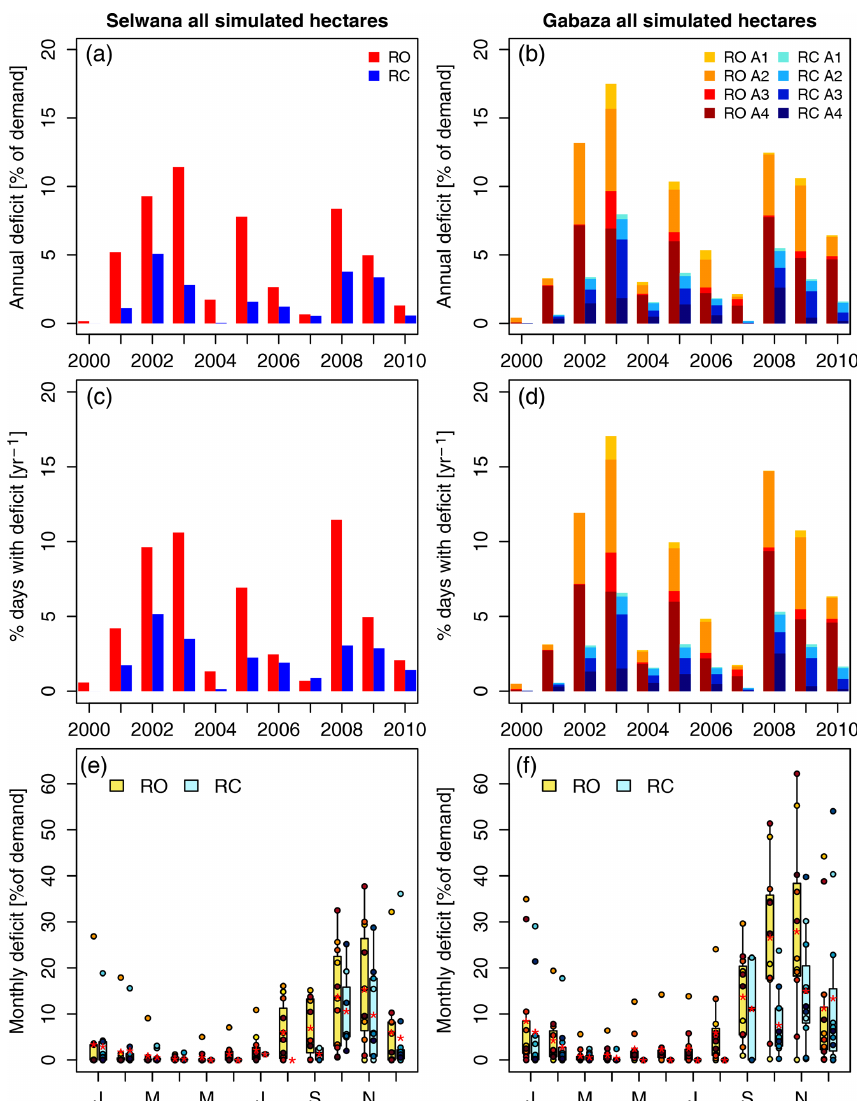
Figure 9. The demand-specific annual deficit across all simulated hectares, and the percentage of grazing days integrated across all simulated hectares that had a deficit (irrespective of the size of the deficit), relative to the total grazing days within a year. Panel (a) shows the relative deficits for Selwana, and panel (b) presents the relative deficits for Gabaza. Panel (c) shows the percentage of grazing days with a deficit for Selwana, and panel (d) displays the percentage of grazing days with a deficit for Gabaza. The subdivisions of bars in panels (b) and (d) indicate the relative contribution of each sub-area to the site-scale annual deficit and days with deficit, respectively. Panels (e) and (f) show the monthly demand-specific deficits across all simulated hectares per village for Gabaza and Selwana, respectively. Red asterisks denote mean values, and white dots denote annual